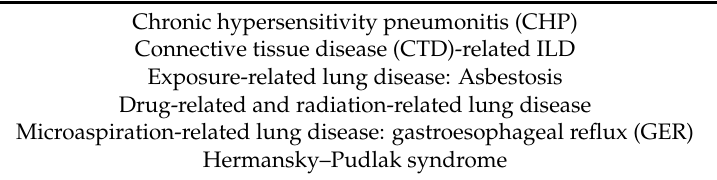
Table 3. Known Causes with an UIP